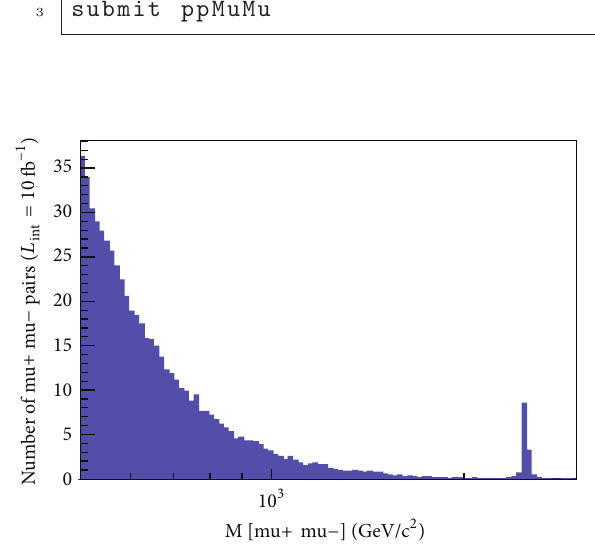
Figure 10: Invariant mass of the 𝜇